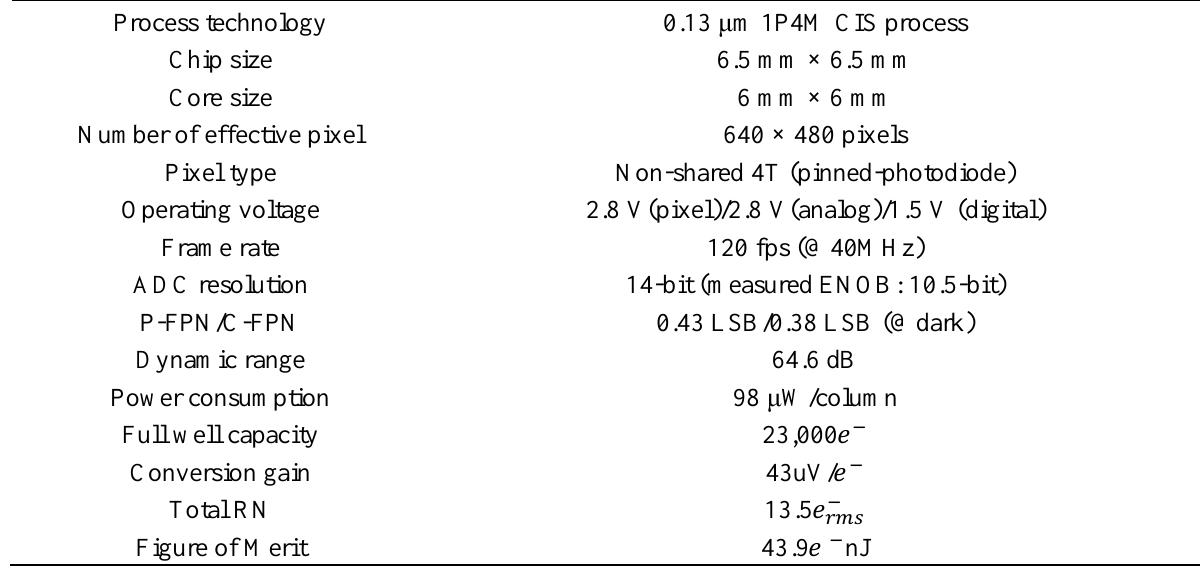
Table 1. Summary of the measured CIS